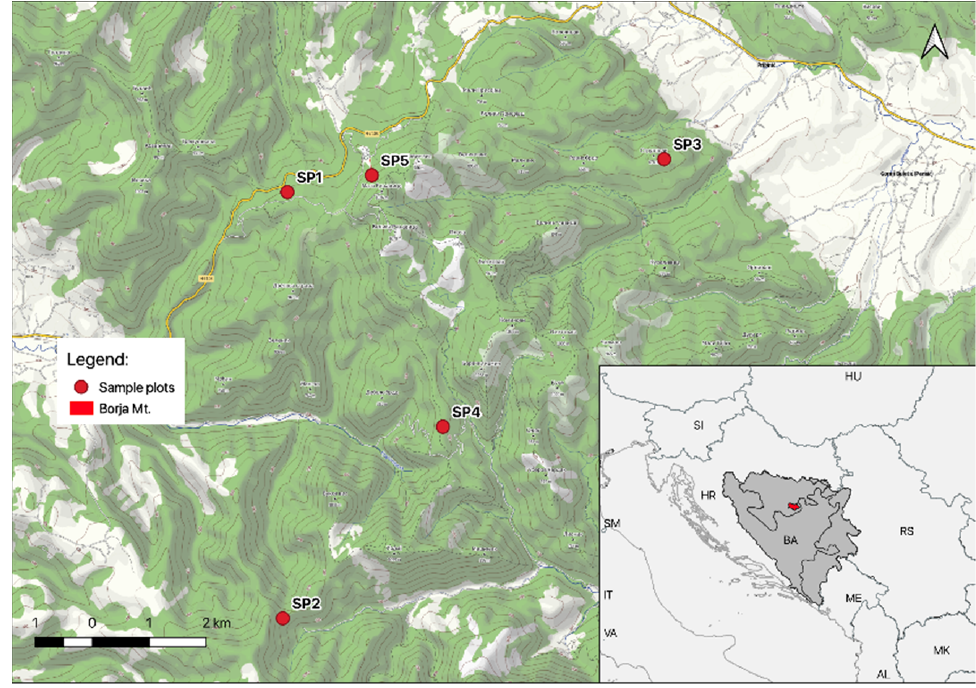
Figure 1. Study area and location of sample plots.